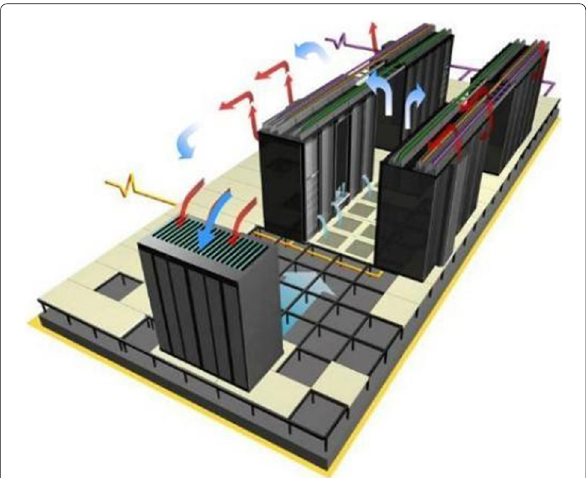
Fig. 1 A typical data center model